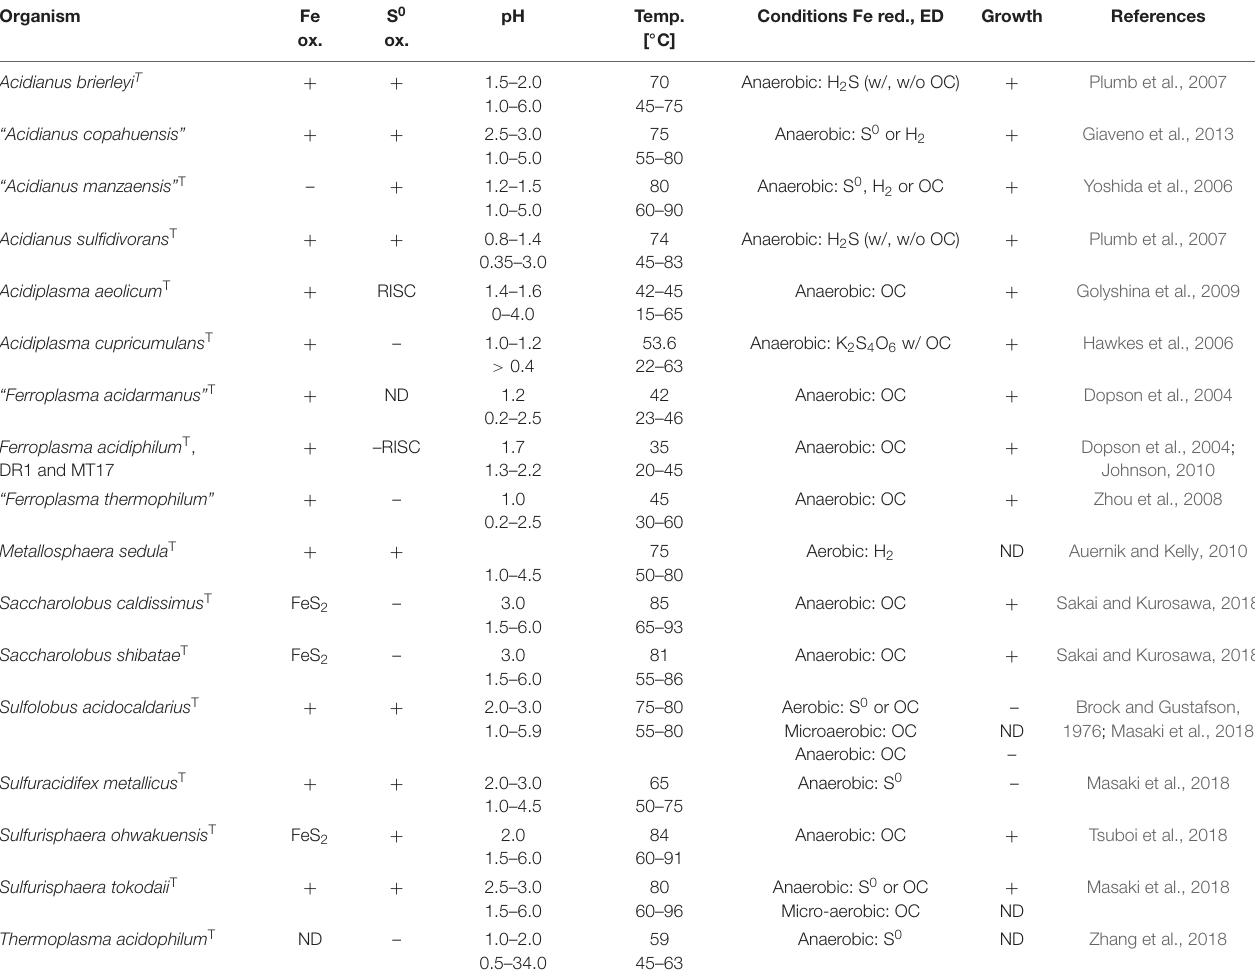
TABLE 2 | Ferric iron-reducing extreme acidophilic